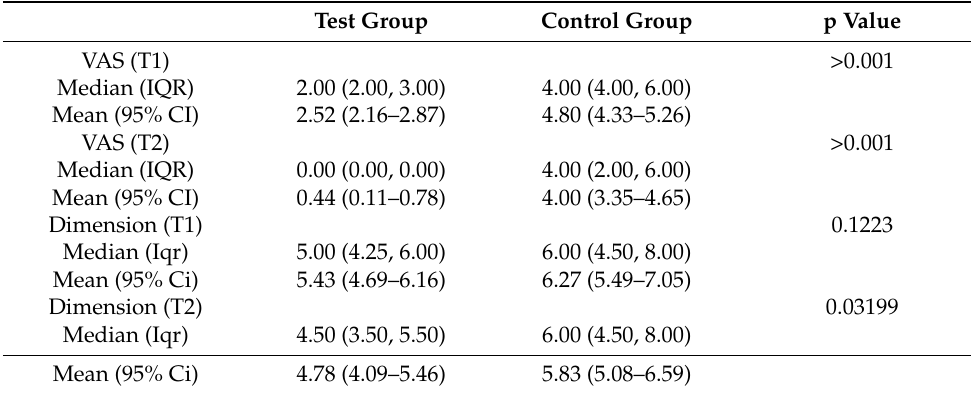
Figure 5. Graphic describing the mean VAS score reported by patients in the test group and control group at T0, T1 and T2. Table 1. Demographic variables and qualitative clinical variables at baseline (T0).